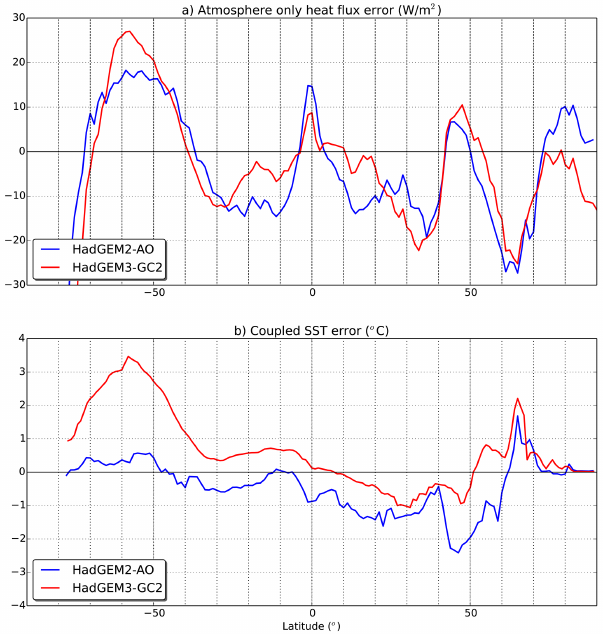
Figure 2. (a) Zonal mean net downward surface flux bias in AMIP simulations. The observed surface flux is a developmental version of the University of Reading surface flux product which combines satellite-based radiative fluxes (Allan et al., 2014) with re-analysis estimates of atmospheric column energy storage and horizontal di- vergences (Liu et al., 2015). (b) Zonal mean SST bias against EN3 for years 5–15 of the coupled model CLIM experiment (before any biases from the deep ocean influence the SSTs).